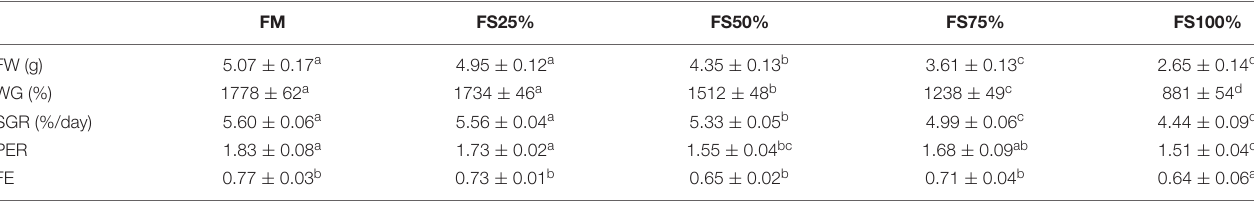
TABLE 5 | Growth performance of shrimps fed with different experimental diets for eight weeks (means of triplicate ± SD). FM FS25%